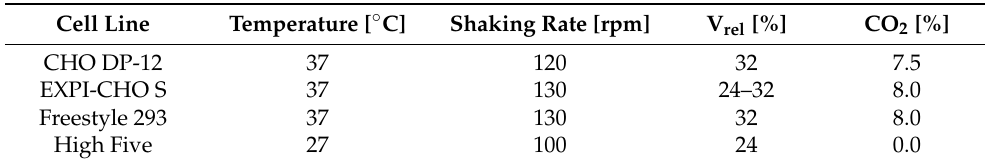
Table 6. Cultivation conditions for the selected cell lines including shaker temperature, shaking rate, relative filling volume (V rel ) and CO 2 concentration in the incubator atmosphere. Humidity was set to 80% for all experiments. Cell Line Temperature [ ◦ C] Shaking Rate